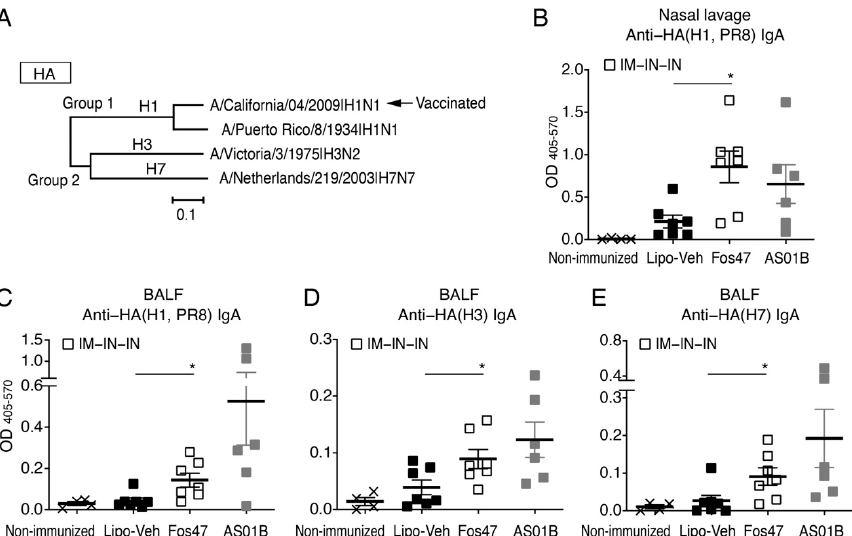
Figure 2. Cross-reactive IgA was induced by IN boosting with Fos47. ( A ) Phylogenetic analysis of influenza virus strains used in the cross-reactivity study. Amino acid sequences of HA proteins used in ELISA were aligned by the MUSCLE algorithm using the Influenza Research Database. Phyloge- netic trees were constructed by the neighbor-joining method using MEGAX software. A/Califor- nia/04/2009(H1N1pdm09) was used for vaccination. Cross-reactivity against antigenically distinct heterologous virus strains, A/Puerto Rico/8/1934(H1N1), A/Victoria/3/1975(H3N2) and A/Nether-